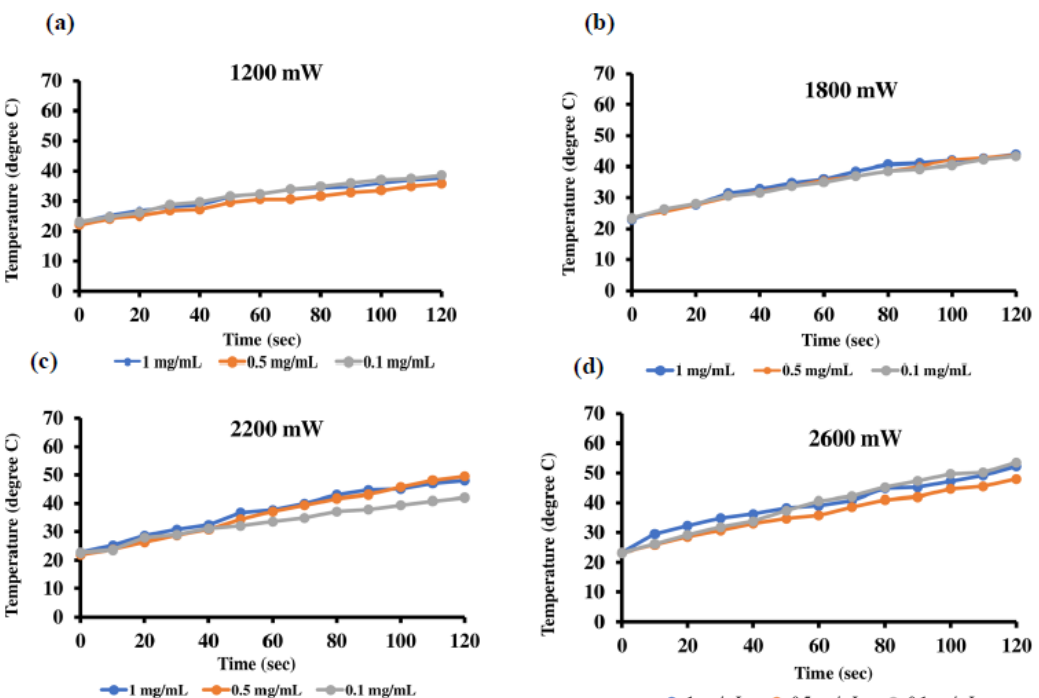
Figure 5. The photothermal evaluations of laser absorption of WS 2 / CoFe 2 O 4 @Fe 3 O 4 nanocomposites in various laser power densities of ( a ) 1200, ( b ) 1800, ( c ) 2200 and ( d ) 2600 mW at concentration 1, 0.5, and 0.1 mg/mL.